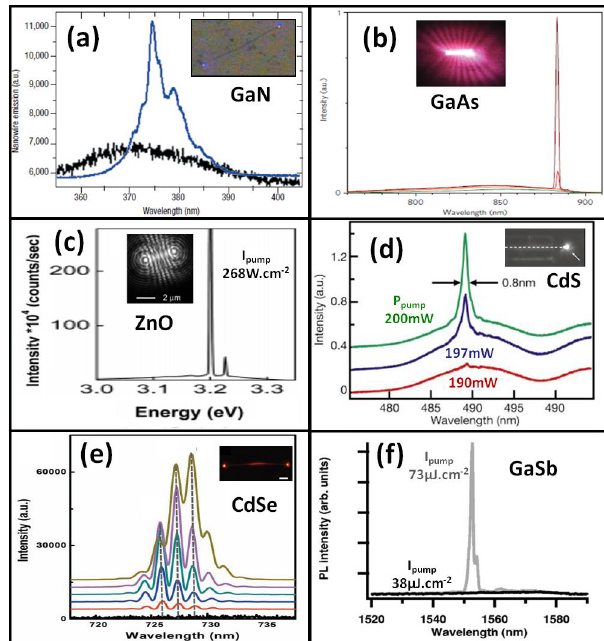
Figure 1: Semiconductor nanowire lasers of different materials. (a) GaN with a photoluminescence spectrum at 1 mW continuous wave excitation (black) and lasing with pulsed 1 nJ/cm 2 excitation (blue) (adapted with permission [45]). (b) GaAs nanowire with transition spectra from spontaneous emission with 144 µ J/cm 2 per pulse (green) and 202 µ J/cm 2 per pulse (orange) to stimulated emission with 240 µ J/cm 2 per pulse (red) and 288 µ J/cm 2 per pulse (brown) (adapted with permission [87]). (c) Stimulated emission spectra of a single ZnO nanowire (adapted with permission [95]). (d) Transi- tion spectra from spontaneous (red) to stimulated (blue and green) emission of an electrically driven CdS nanowire laser for different pump powers (adapted with permission [24]). (e) Emission spec- tra of a CdSe nanowire by increasing pumping intensity from 69 to 547 µ J/cm 2 above the threshold (adapted with permission [55]). (f) GaSb transition spectra from spontaneous emission (black) to stimulated emission (gray) (adapted with permission [16]).